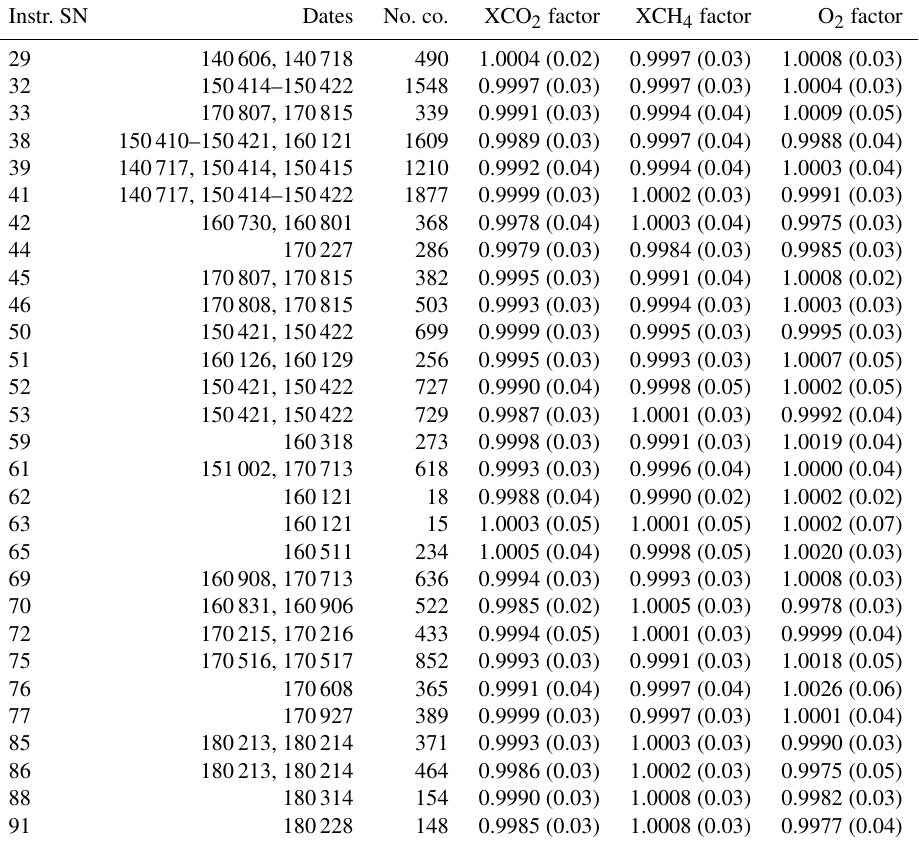
Table 6. Calibration factors for XCO 2 , XCH 4 , and O 2 for all investigated instruments with respect to the reference EM27/SUN spectrometer (SN37) as well as calibration dates and number of coincident measurements. Values in brackets denote percent standard deviations. Instr. SN